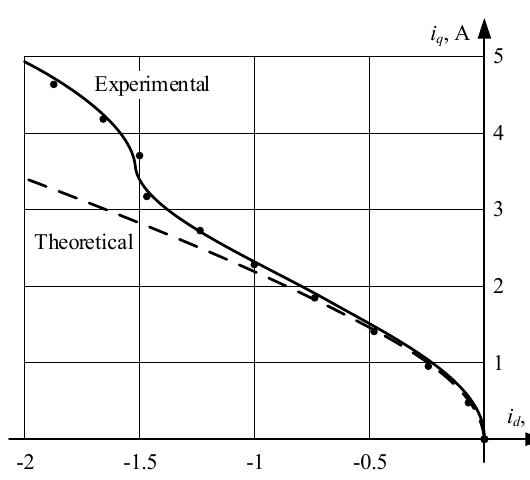
Figure 8. Theoretical and experimental MTPA curves.